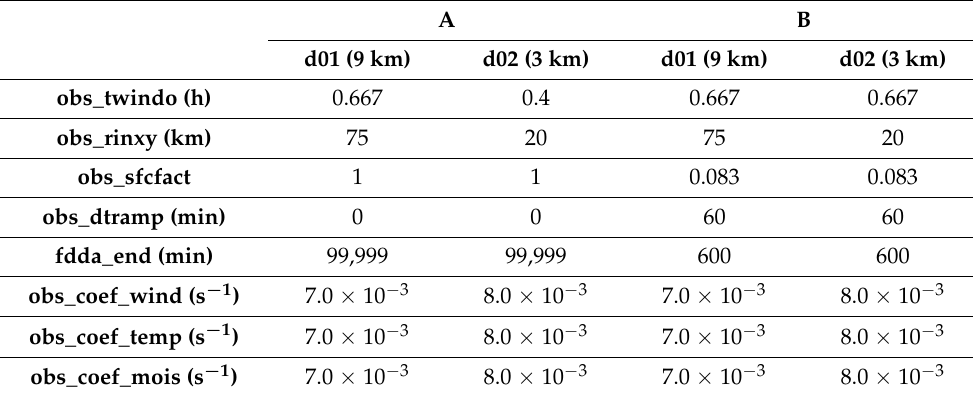
Table A1. Relevant parameters used in the FDDA.